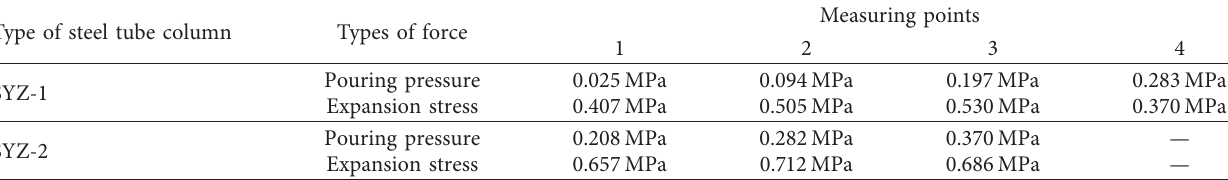
Table 4: Maximum values of pouring pressure and expansion stress at each measuring point of the core concrete. Type of steel tube column Types of